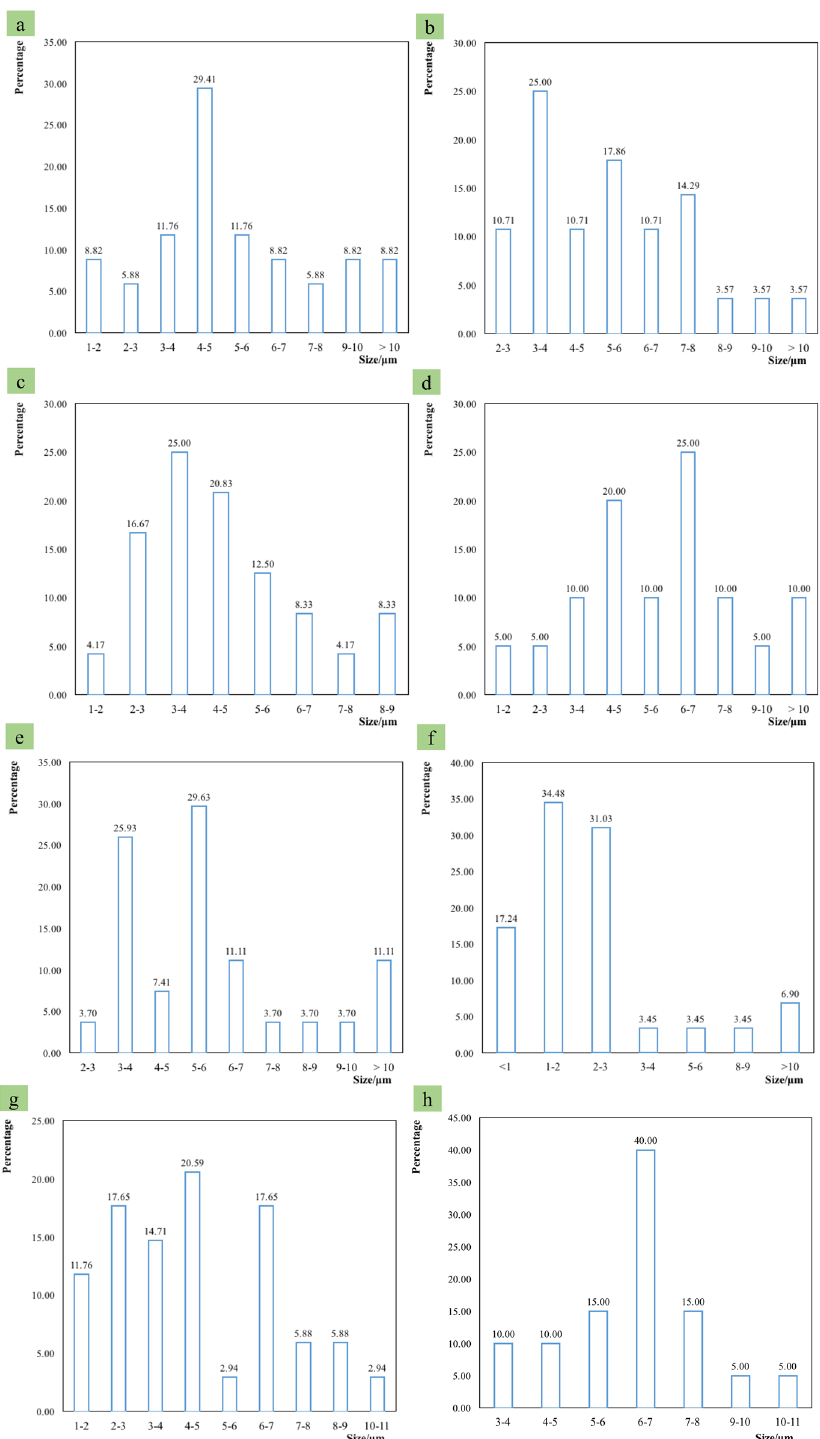
Figure 2. ( a – h ) Inclusion size distributions for different samples during furnace-cooling to room